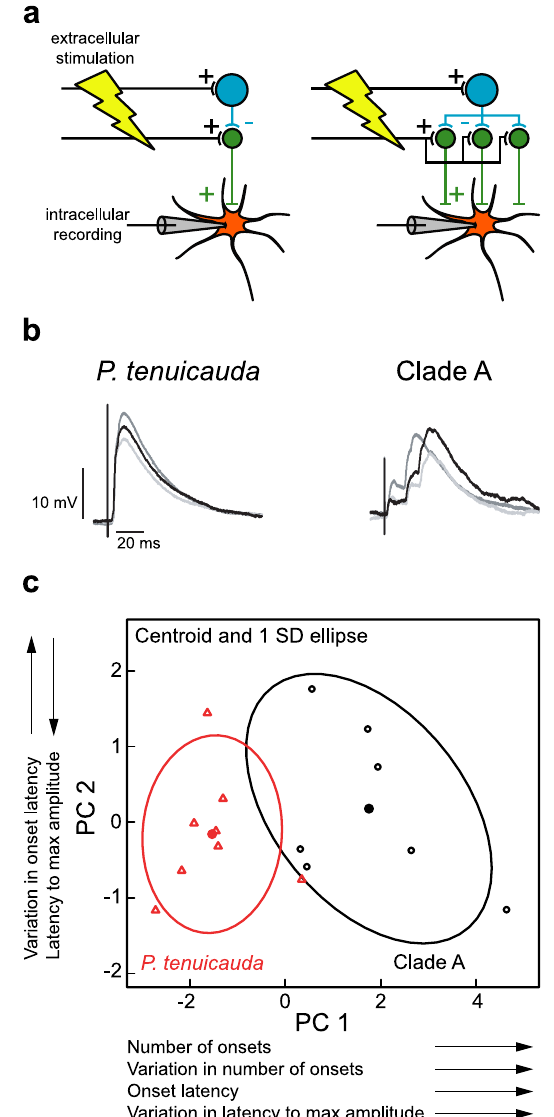
Figure 7. Multipolar cells in ELp receive excitatory inputs at more variable and longer latencies than multipolar cells in EL. ( a ) Schematic of the experiment designed to test whether incoming hindbrain axons act as delay lines in ELa, but not in EL. Extracellular stimulation of axons projecting from the hindbrain to the midbrain through the lateral lemniscus result in excitatory inputs to large inhibitory cells and to small cells. Small cells project to multipolar cells. The cartoon on the left depicts a simple excitatory-inhibitory circuit in which output from small cells to multipolar cells come shortly after stimulation of the lateral lemniscus. On the right, the circuit includes delay lines in the projections onto small cells. Because delay lines cause inputs to small cells to be delayed by different amounts, outputs from small cells to multipolar cells will be delayed by different amounts. Therefore, excitatory postsynaptic potentials (EPSPs) of multipolar cells should reveal several excitatory inputs at more variable latencies in circuits with delay lines. ( b ) Three traces of representative EPSPs recorded from one multipolar cell in EL of P . tenuicauda (left) and one multipolar cell in ELp of a clade-A species ( B . niger , right). The EPSPs of the clade-A species do indeed reveal several excitatory inputs with a greater range of latencies than the EPSPs of P . tenuicauda . ( c ) The six variables used to describe the EPSP curves (see main text and Methods) can be summarized by two principal components. The first principal component (PC1) has an eigenvalue of 4.3, explains 72% of the variation, and loads heavily ( > 0.4) on the median and standard deviation in the number of onsets, the median latency of the onsets, and the standard deviation in the latency to the maximum amplitude of the EPSP. The second principal component (PC2) has an eigenvalue of 0.85, explains an additional 14% of the variation, and loads heavily ( > 0.45) on the median latency to reach the maximum amplitude of the EPSP and the standard deviation in the latencies of the onsets. Scores of the first principal component (PC1) were higher in B . niger , the clade-A species (black, n = 7), than in P . tenuicauda (red, n = 8). The current pulses used to obtain the traces in ( b ) were delivered at an amplitude of 160 µ A for P . tenuicada and 120 µ A for clade A (see